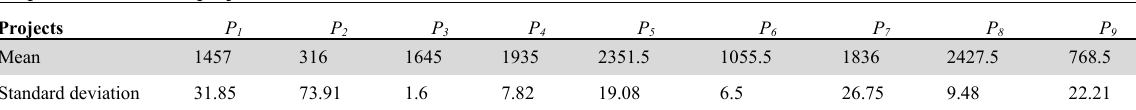
The parameters of the projects cost normal distribution Projects